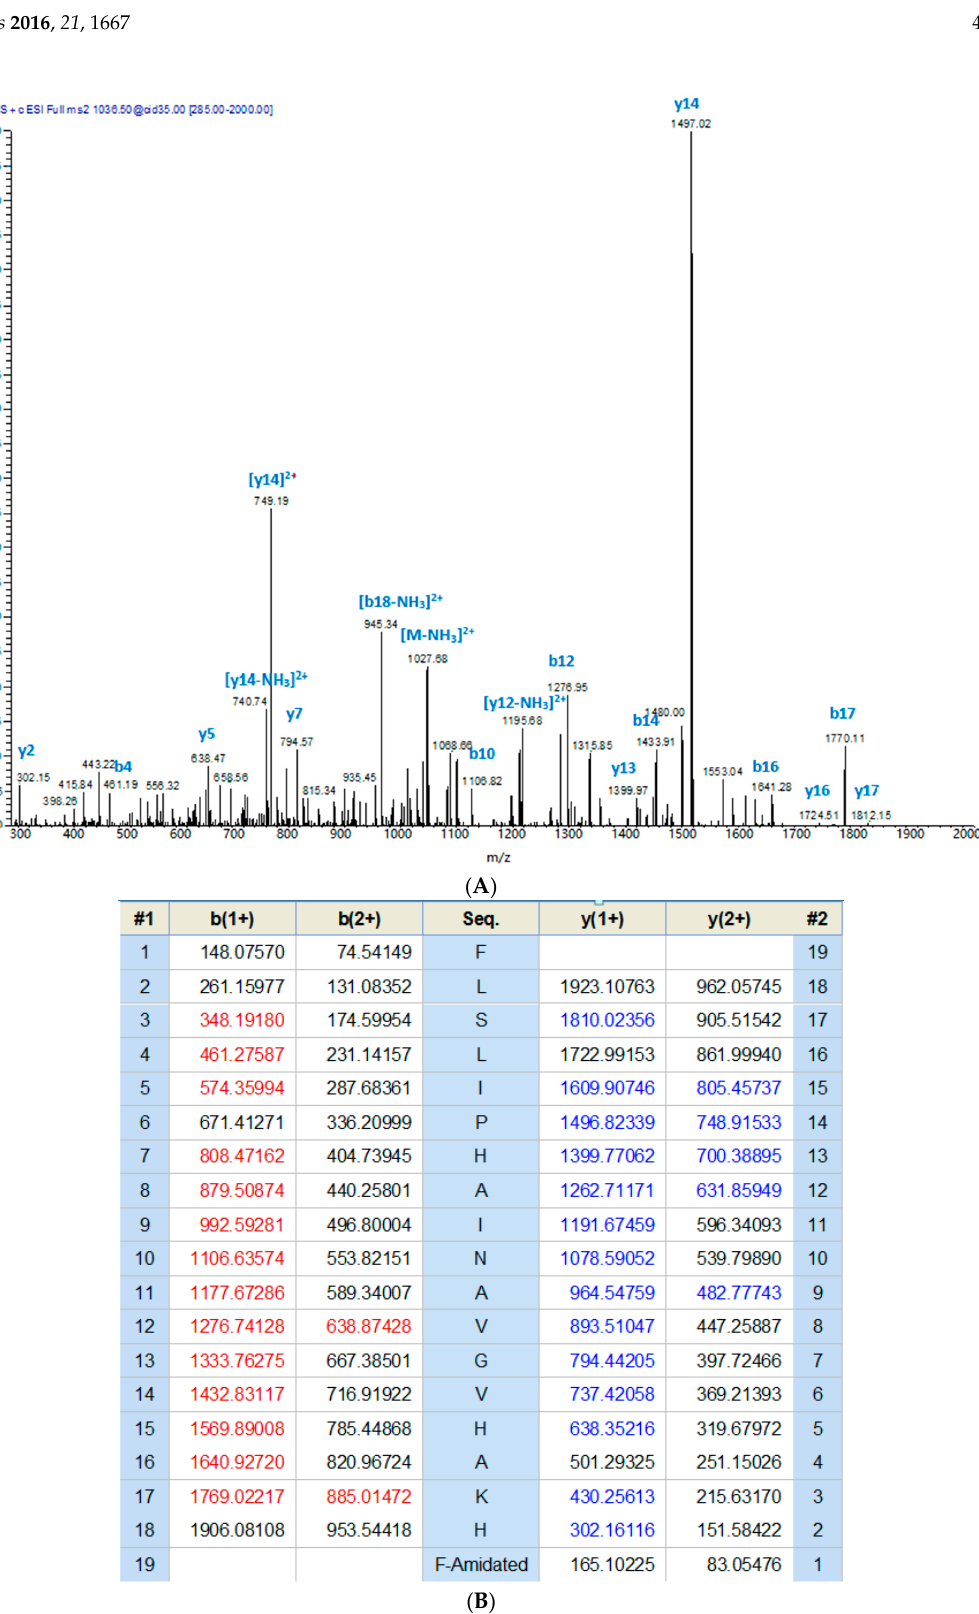
Figure 3. Ion spectrum of phylloseptin-PT ( A ) MS/MS data from collision-induced dissociation of the doubly-charged precursor ion (1036.50 m / z ). ( B ) The calculated fragment ions from the sequence with those observed following MS/MS indicated in blue and red typefaces.